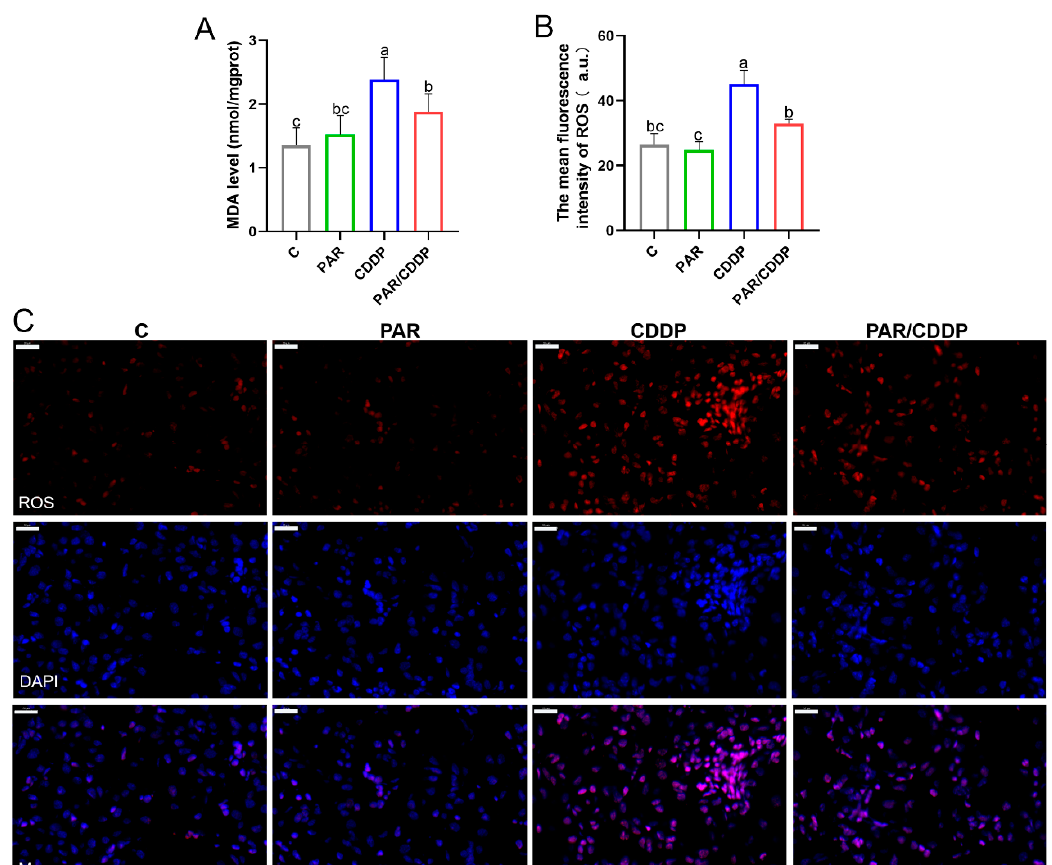
Figure 2. Effect of paricalcitol on oxidation products in mice kidneys. ( A ) The content of MDA in mice kidneys ( n = 6). ( B , C ) Representative images and quantification of ROS (red) detection by fluorescence microscopy (scale bars, 20 µ m; n = 3). C, control group; PAR, paricalcitol group; CDDP, cisplatin group; PAR/CDDP, paricalcitol + cisplatin group. Bars that do not share the same letters are significantly different ( p < 0.05) from each other. Results are presented as Mean ± SD. Statistical significance was obtained by one-way ANOVA.